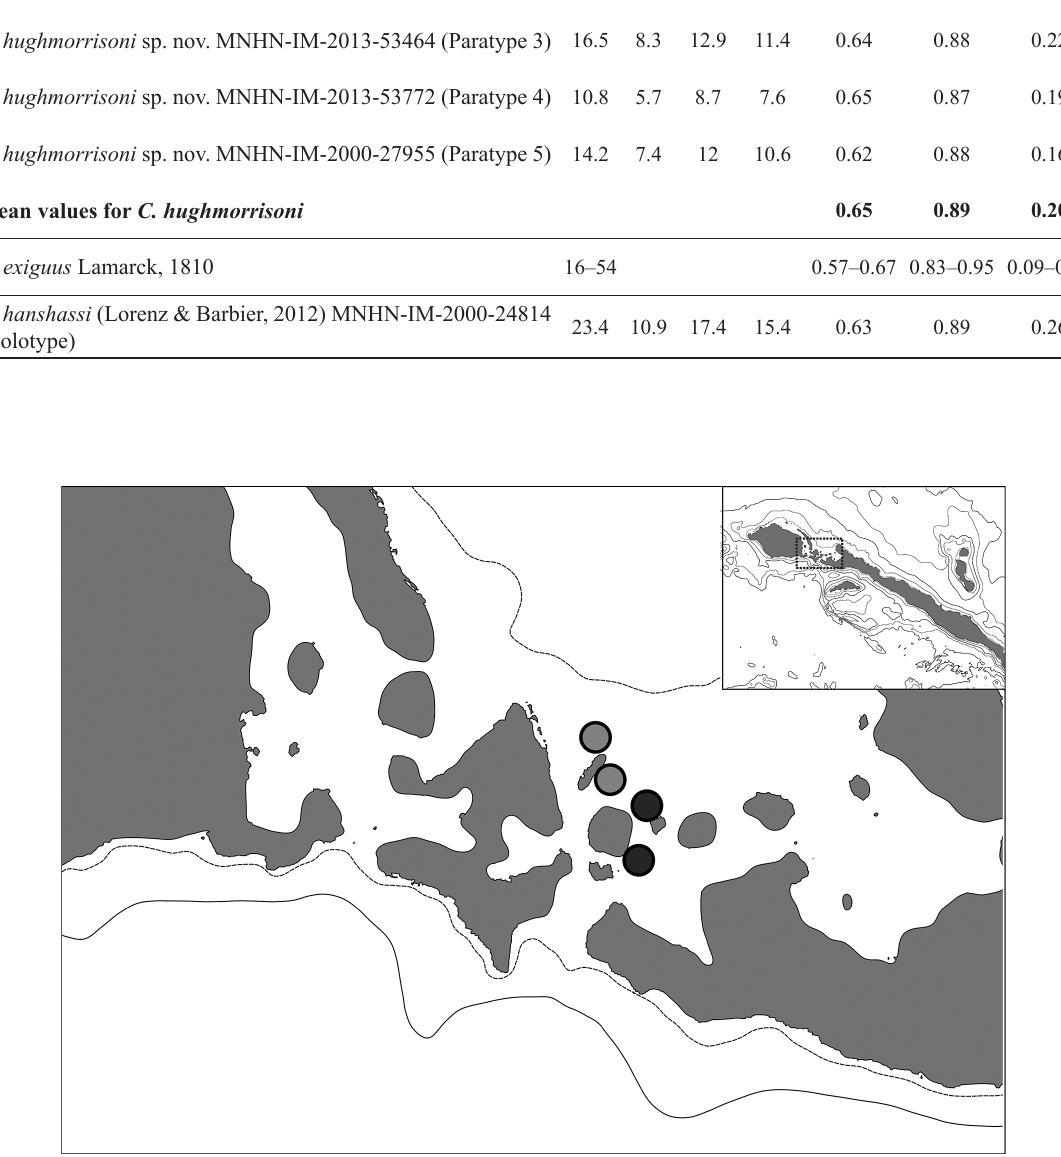
Fig. 5. Map of the Kavieng Region showing the different sampling sites. Black circles: stations with sequenced material; grey circles: stations with other